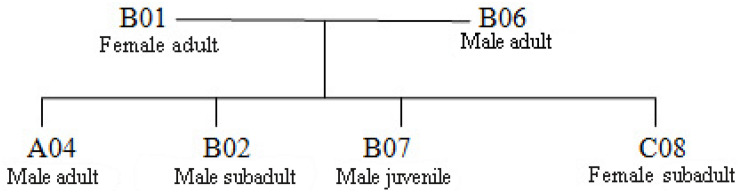
Genetic maps of 3 Hainan gibbon groups.